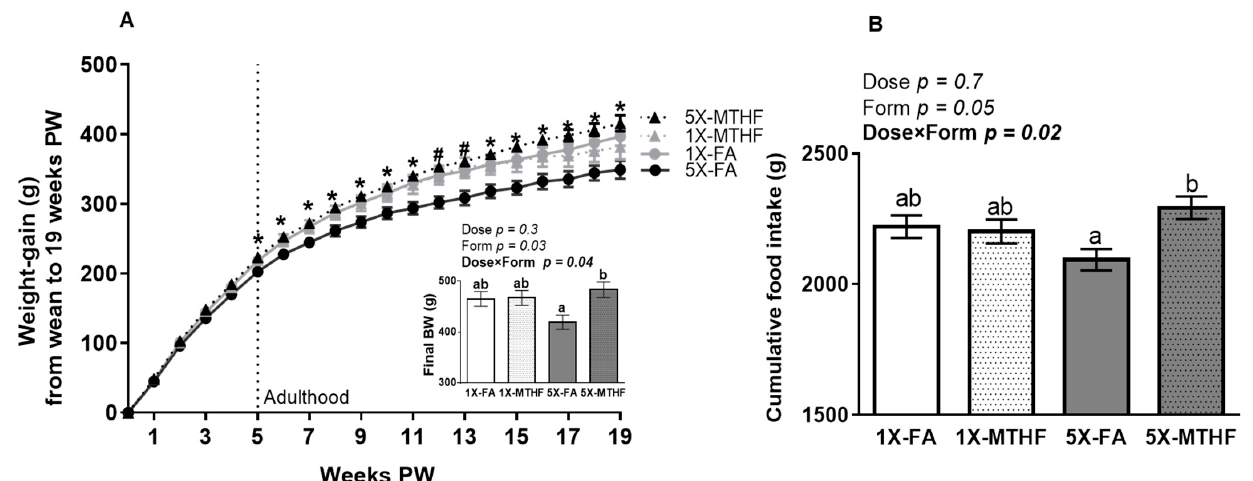
Figure 1. ( A ) Weekly body weight gain, final body weight (g), and ( B ) cumulative food intake (g) of female offspring fed a high-fat diet from wean to 19 weeks post-weaning (PW). Values are least square Mean ± standard error of the mean (S.E.M.), n = 10-12/group. Weight gain over time was calculated using a Repeated Measures ANOVA, Diet p = 0.02, Time p < 0.0001 and Diet × Time p < 0.001. Significant interaction effect was followed by Tukey post-hoc analysis. Significant differences ( p < 0.05) between the 5X-FA and 5X-MTHF female offspring only are indicated by an asterisk (*). Significant differences ( p < 0.05) between the 5X-FA compared to both the 5X-MTHF and 1X-MTHF offspring are indicated by a number symbol (#). Values in bold indicate significant effects. Final body weight and cumulative food intake analyzed by two-way ANOVA with Dose (1X or 5X) and Form (FA vs. MTHF) as main factors and a Dose × Form interaction term. Different letters (a,b) indicate significant differences at p < 0.05 by Tukey’s post-hoc analysis. Abbreviations: AIN-93G rodent diet with either 1X-FA, recommended folic acid (2 mg/kg diet); 5X-FA (10mg/kg diet); 1X-MTHF, equimolar recommended [6S]-5-methyltetrahydrofolic acid calcium salt (2.1 mg/kg diet); or 5X-MTHF (10.4 mg/kg diet). Dotted line represents post-weaning time point at which rodents become young